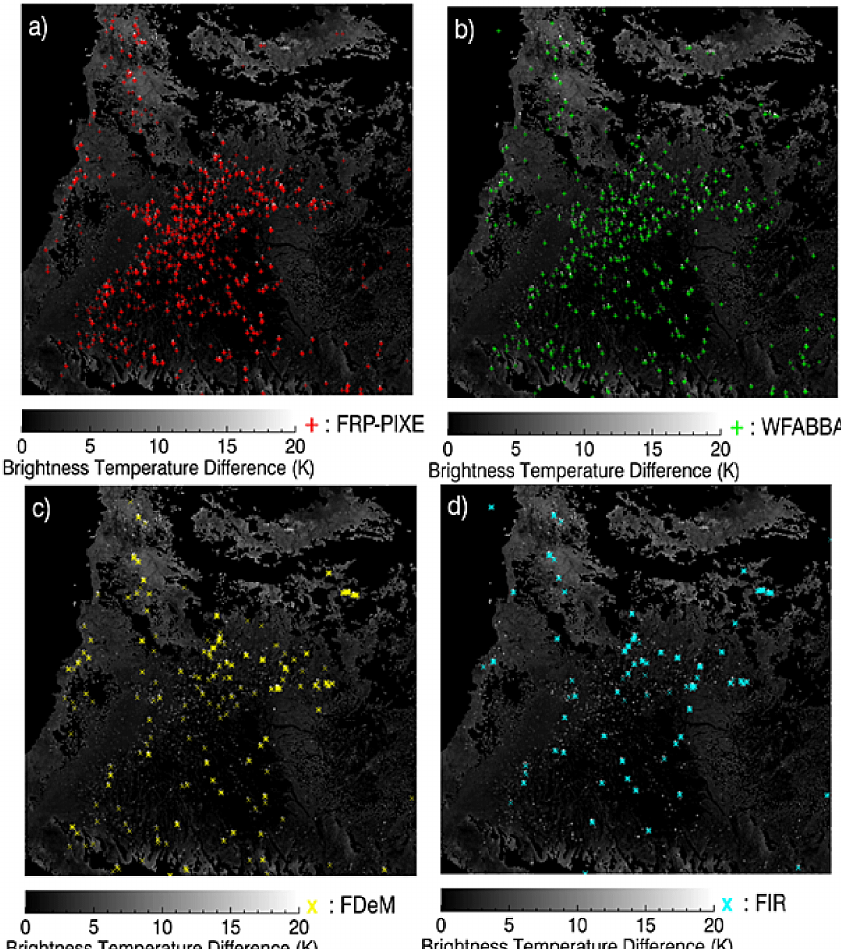
Figure 4. Example of the active fire pixel detections contained within the four SEVIRI-derived active fire detection products studied herein (LSA SAF FRP-PIXEL product; Wooster et al., 2015, WF-ABBA; Prins et al., 1998, FDeM; Amraoui et al., 2010, and FIR; Joro et al., 2008). The images are produced from a single SEVIRI time slot (13:15UTC on 21 August 2014) and show the active fire detections made in (a) FRP-PIXEL (1249 active fire pixel detections), (b) WFABBA (filtered version; 686 detections made), (c) FDeM (346 detections) and (d) FIR (312 detections). The underlying greyscale image is the SEVIRI brightness temperature difference image (3.9–10.8µm channels) from the same imaging slot. Water bodies and clouds have been masked out (black). The region shown is that over Angola in the Southern Africa LSA SAF geographic region (Fig. 1). It is clear than whilst all the products tend to detect a reasonable number of fires that are comprised on multiple SEVIRI active fire pixels, it is the FRP-PIXEL and WF-ABBA products that detect more of the single pixel fires, with the FRP-PIXEL product dominating in this